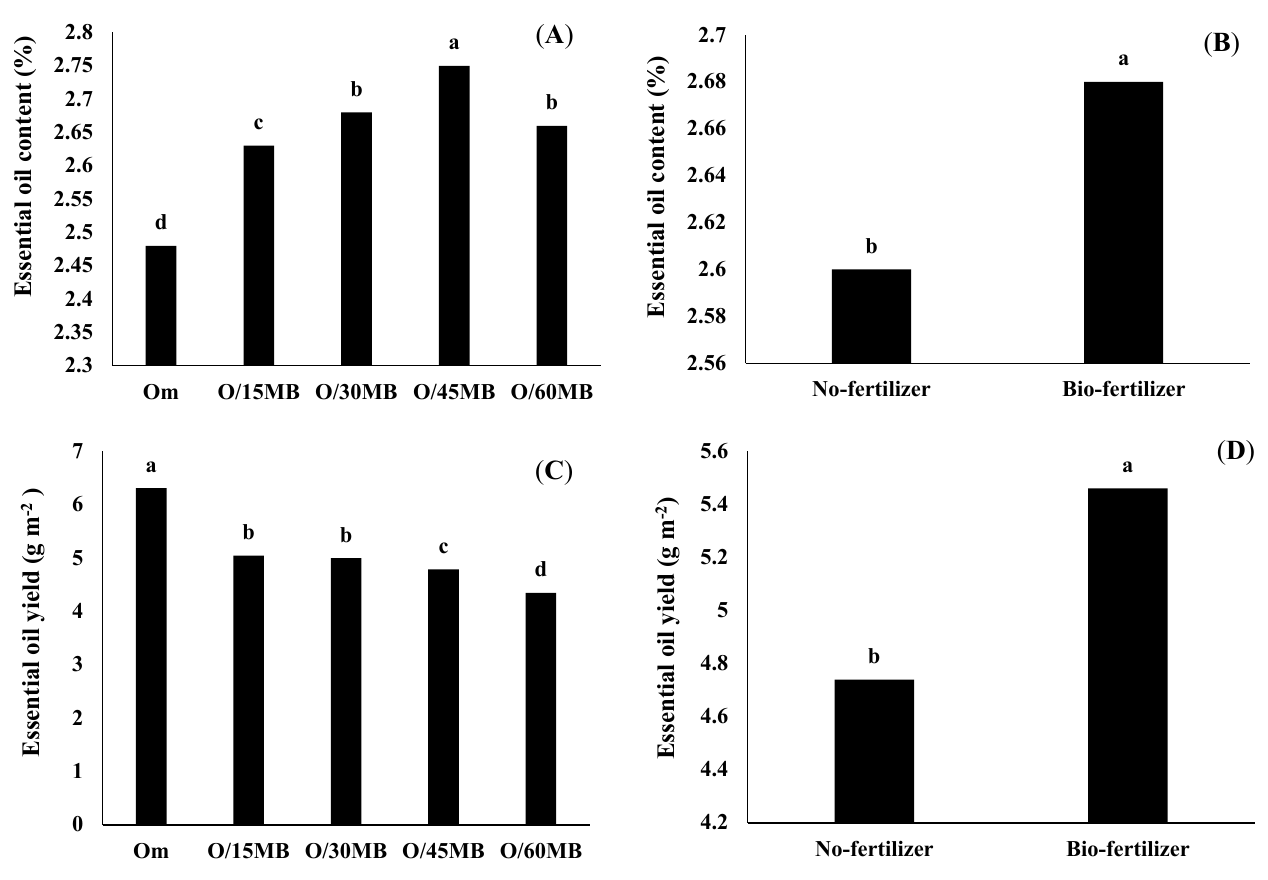
Figure 4. The main effect of cropping patterns ( A , C ) and fertilizer application on the essential oil content and essential oil yield of marjoram ( B , D ). Om: marjoram monocropping; O/15MB: inter ‐ cropping ratios of 100% marjoram + 15% mung bean; O/30MB: 100% marjoram + 30% mung bean; O/45MB: 100% marjoram + 45% mung bean; O/60MB: 100% marjoram + 60% mung bean. Different lower ‐ case letters above the bars indicate significant ( p ≤ 0.05) differences.